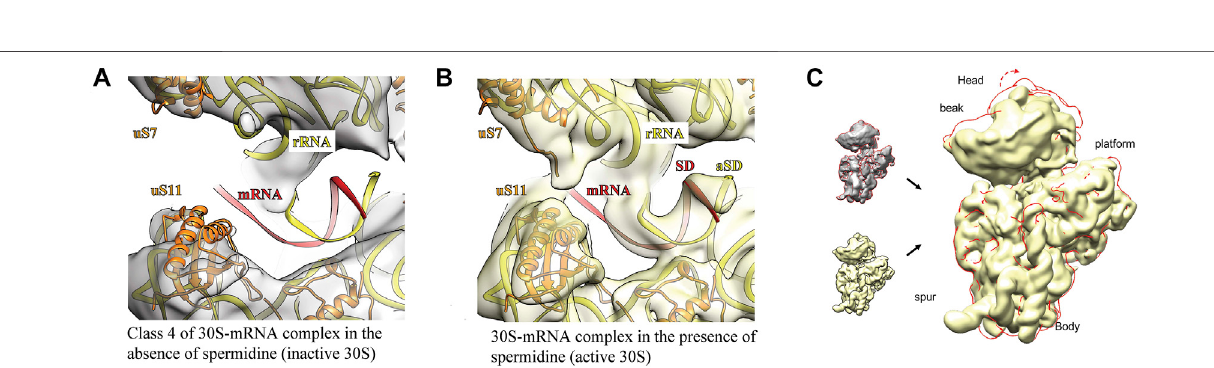
Frontiers in Molecular Biosciences |